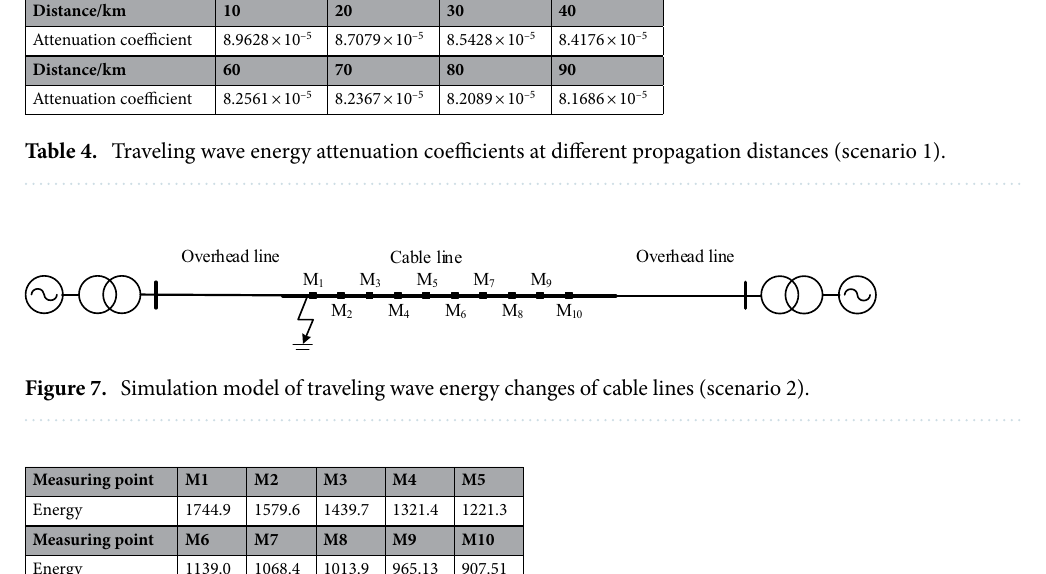
Table 5. Traveling wave energy at different measuring points on the cable line (Scenario 2).